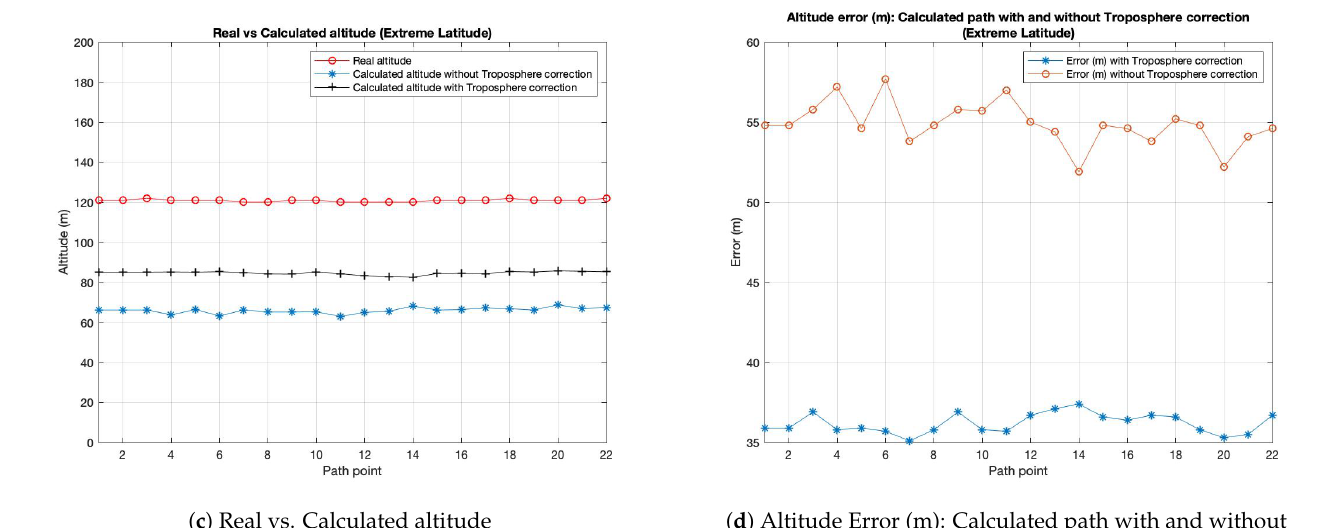
Figure 8. Experimental results for Extreme Latitude (route in